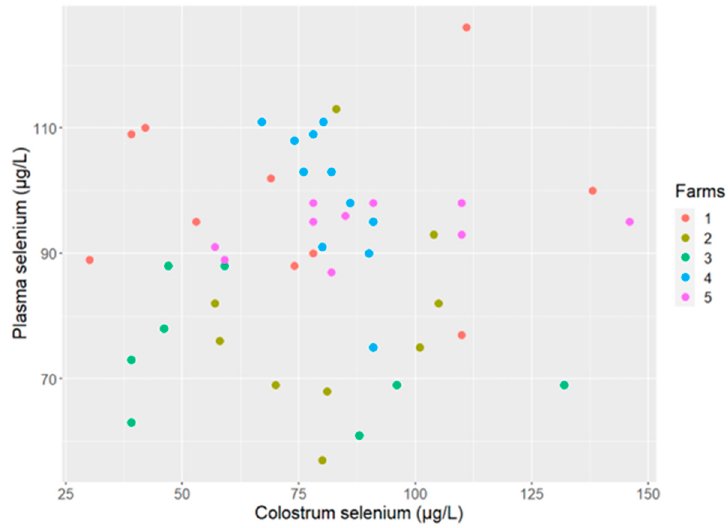
Figure 2. Scatter plot of plasma selenium concentration vs. colostrum selenium concentration.